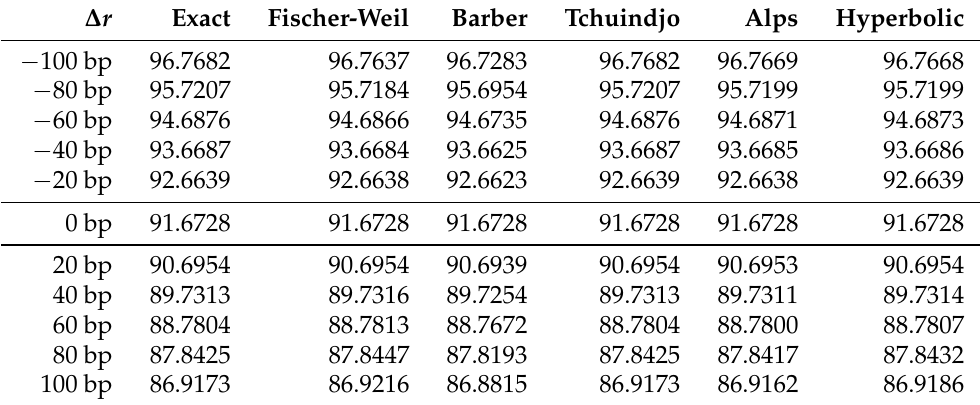
Table 1. PV of 10-year annuity with annual payments of 10. ∆ r